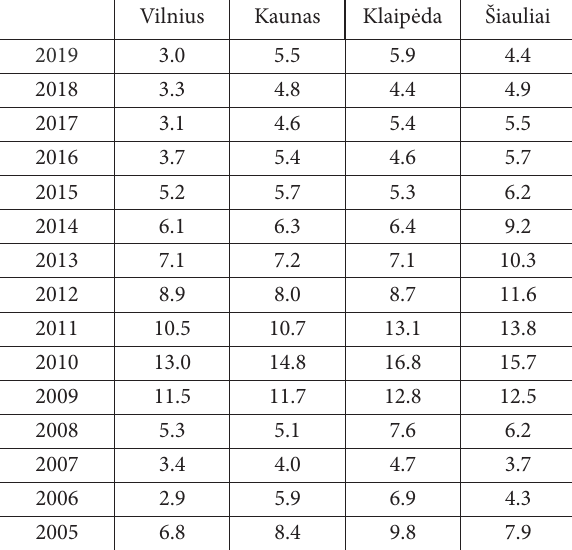
Table A4. Unemployment rate in Lithuanian cities in 2005−2019 (%) Vilnius Kaunas